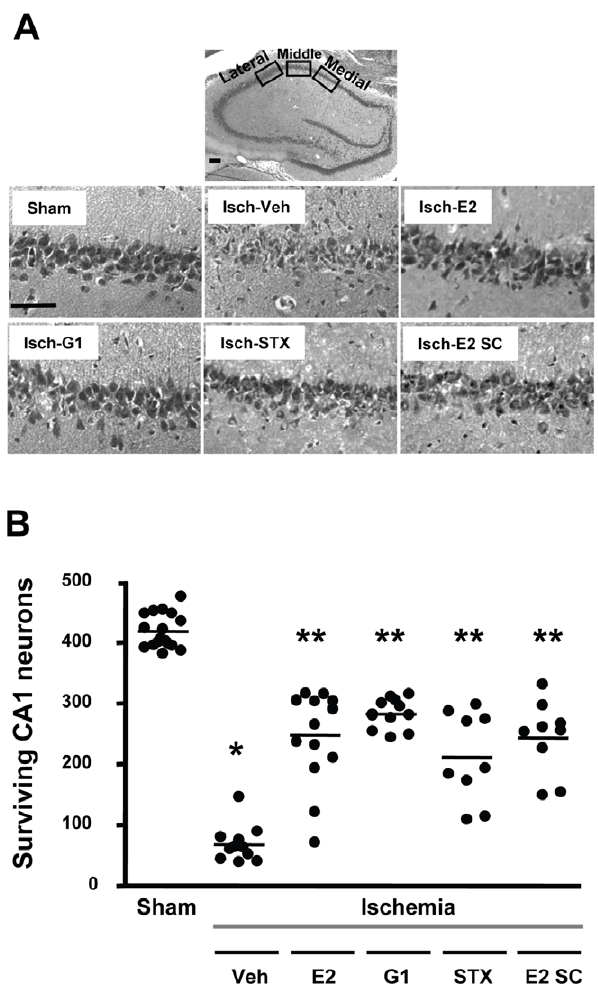
Figure 4. E2, G1 and STX afford neuroprotection in middle- aged females 8 weeks after hormone deprivation. Middle-aged female rats were subjected to sham surgery or global ischemia (Isch) 8 weeks after OVX. Panel A shows representative photomicrographs of hippocampal neurons in the dorsal CA1 region 7 days after sham surgery or global ischemia in animals injected ICV immediately after reperfusion with either vehicle, E2 (2.25 m g), G1 (50 m g), STX (50 m g) or vehicle. Additional animals were injected sc with E2 (100 m g/kg). Scale bars: low magnification, 400 m m; higher magnification, 60 m m. Panel B: Quantification of living pyramidal neurons was performed in the CA1 region of the hippocampus 7 days after ischemia. Neurons were counted in 3 sectors (lateral, middle and medial) of the dorsal hippocampus. ANOVA followed by Newman Keuls, * p , 0.001 versus sham, ** p , 0.001 versus ischemia/vehicle. doi:10.1371/journal.pone.0008642.g004 measured the field excitatory postsynaptic potential (fEPSP) generated in the CA1 pyramidal cell layer by Schaffer collateral stimulation in hippocampal slices from young OVX female rats.